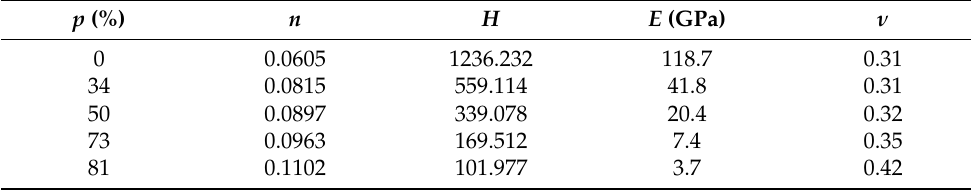
Table 2. Strain hardening exponent ( n ), strength coefficient ( H ), elastic modulus ( E ), and Poisson’s ratio ( ν ) of Ti–6Al–4V at different porosities ( p